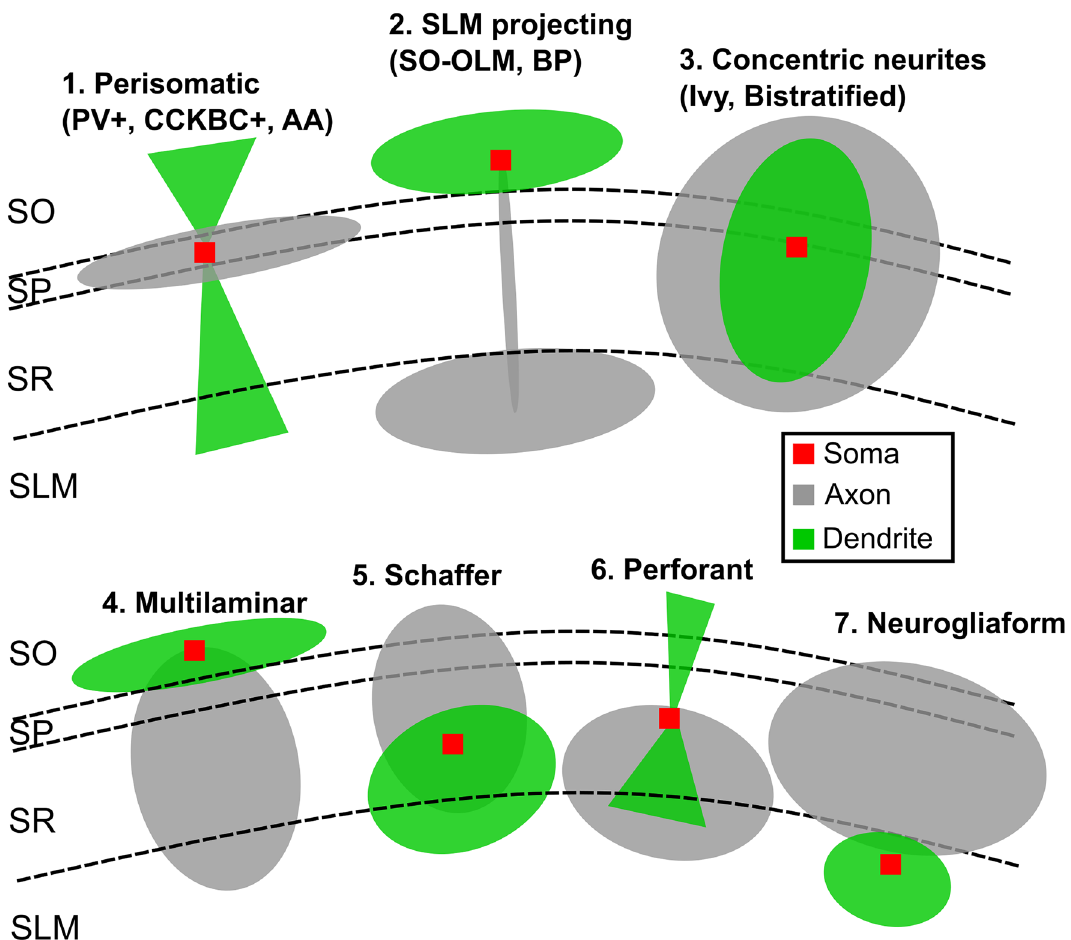
Figure 6. Interneuron morphologies Probability clouds for the classes of morphologies that have been generated to represent the 11 types of interneurons. Red squares indicate the preferential position of the cell soma within the CA1